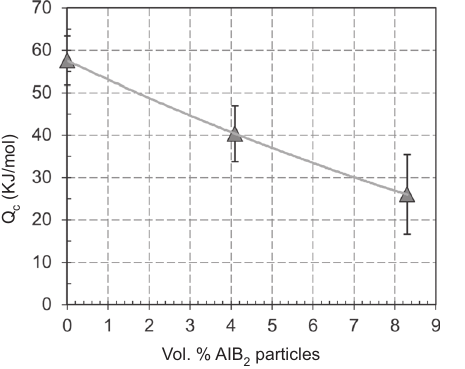
Figure 9 Creep activation energies computed for the Al-Cu matrix composites reinforced with AlB